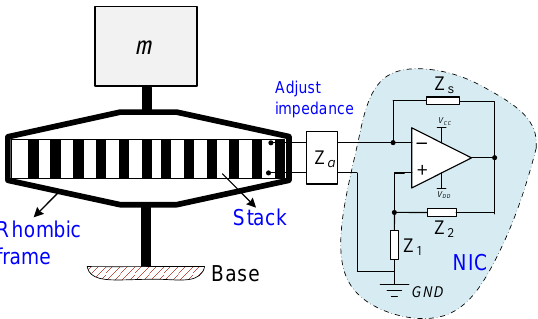
Figure 1. Model of a rhombic piezoelectric stack transducer with a hybrid negative-impedance shunt circuit. Z a is the adjustable impedance of shunt; it can be in series and parallel forms. Z 1 , Z 2 , and Z s are utilized to construct the different types of shunt.